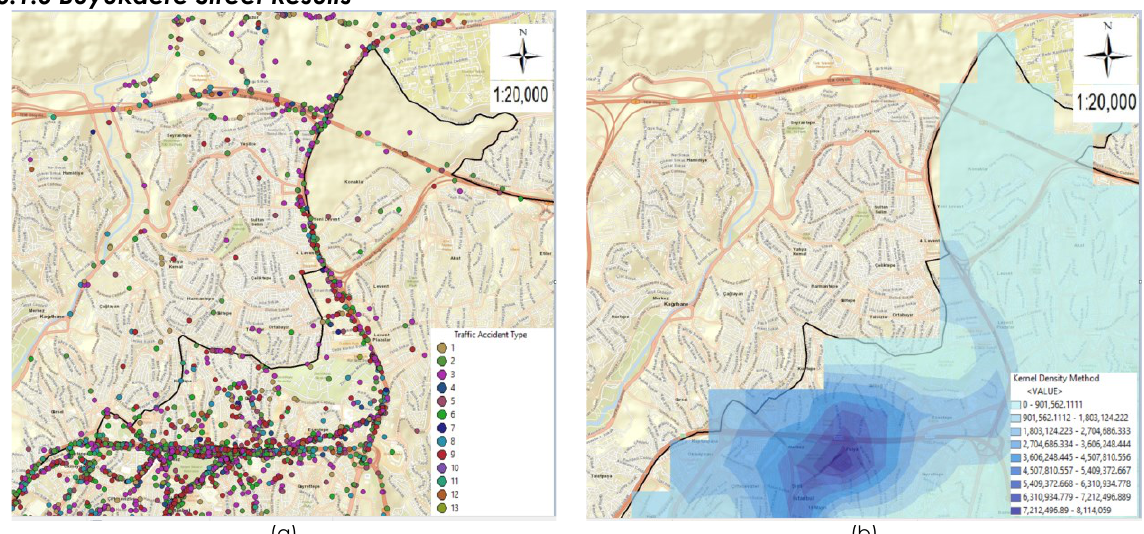
(b) Figure 16. Maps of traffic accidents on Büyükdere Street in Şişli district: (a) Thematic accident map by type of accident; (b) Kernel Density method